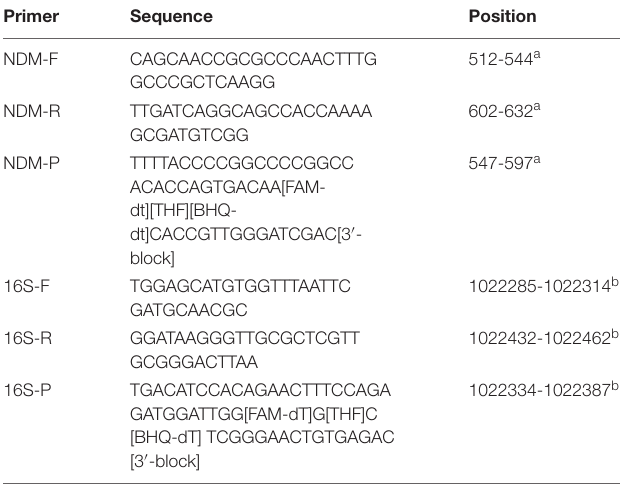
( Figures 2D–F ). Hence, the RAA assay for the detection of bla NDM was specific